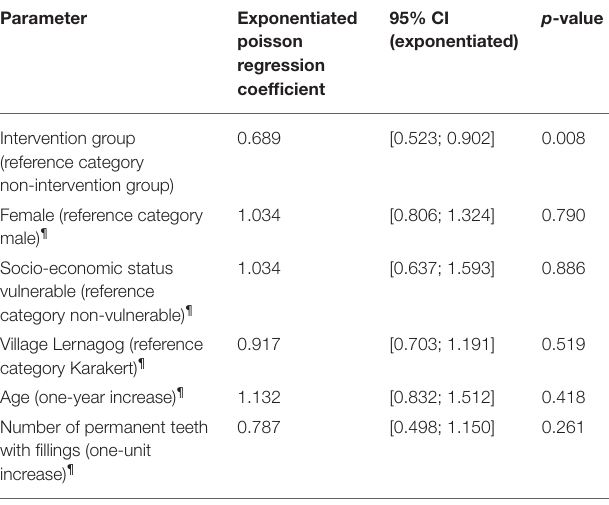
TABLE 4 | Association of participation in the intervention, age, sex, socio-economic vulnerability status, village of residence, the number of permanent teeth with fillings, and the number of permanent teeth with caries, among the 10–11-year-old children from the two